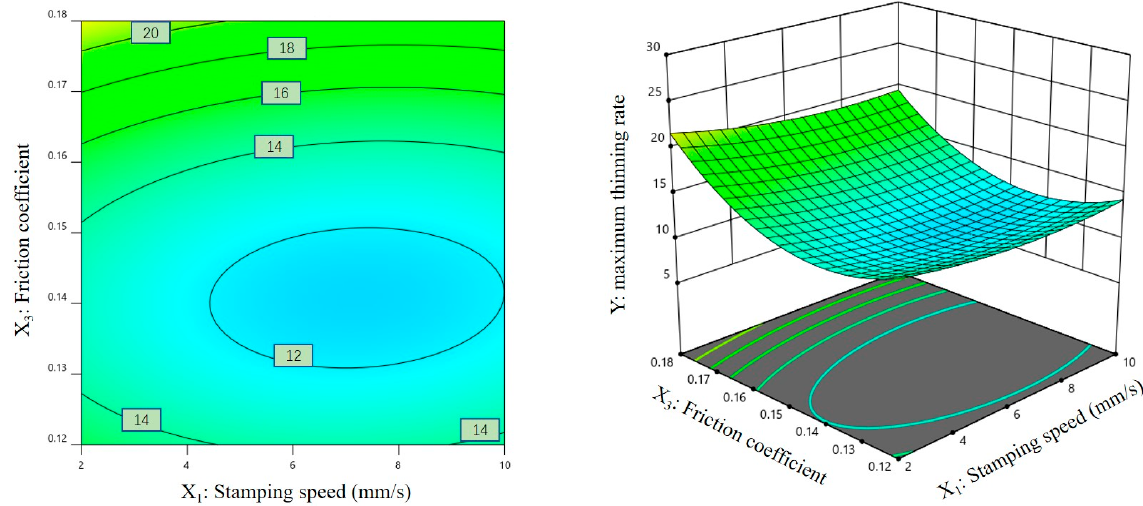
Figure 7. Contour plot and three-dimensional response surface graph of X 1 -X 2 on Y.